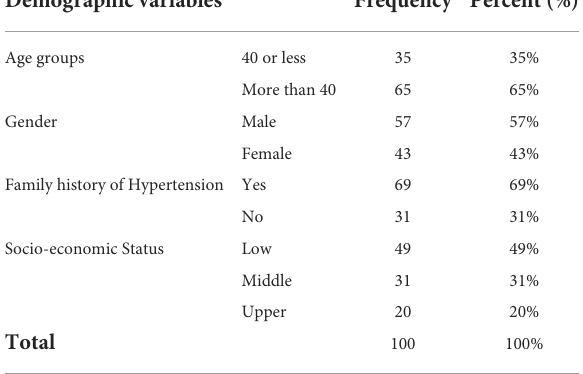
TABLE 1 Demographic profile of the